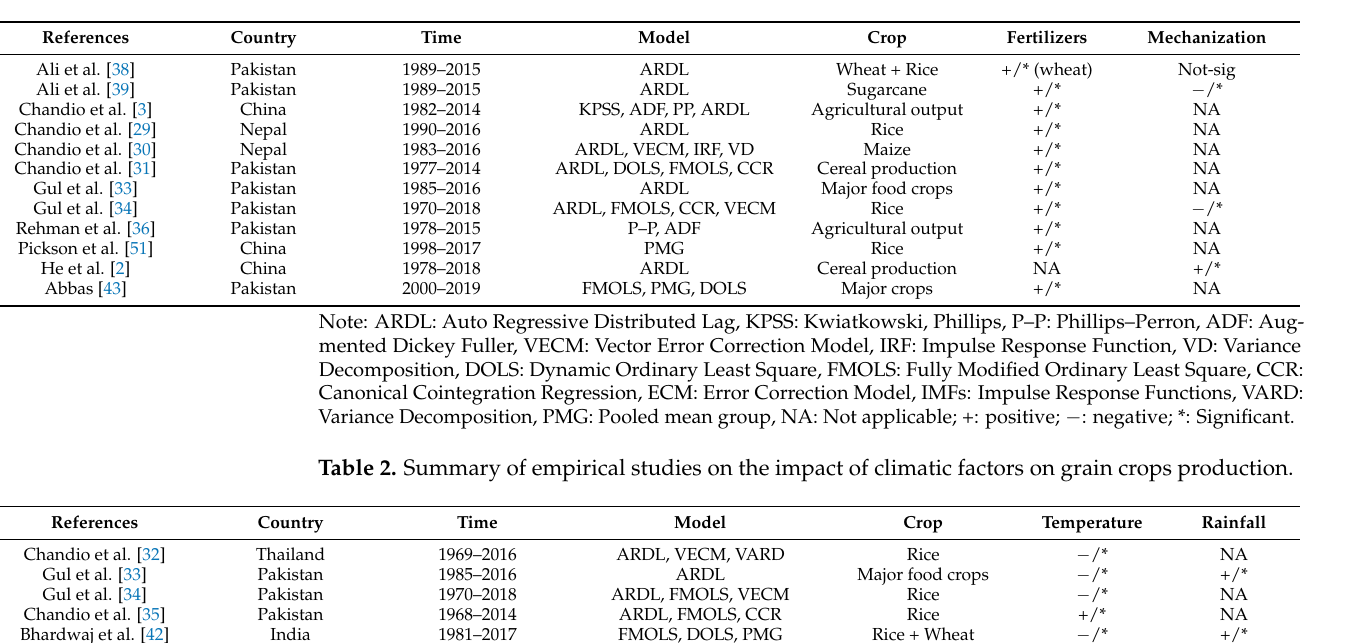
Table 1. Summary of empirical studies on the impact of technical progress on grain crops production.